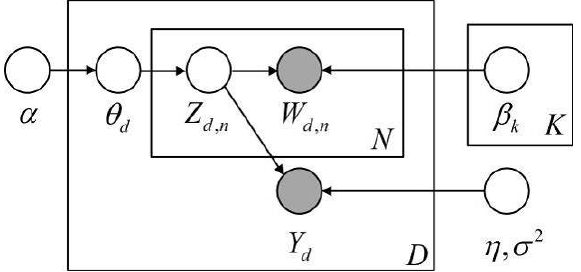
Figure 2. A graphical model representation of Supervised Latent Dirichlet